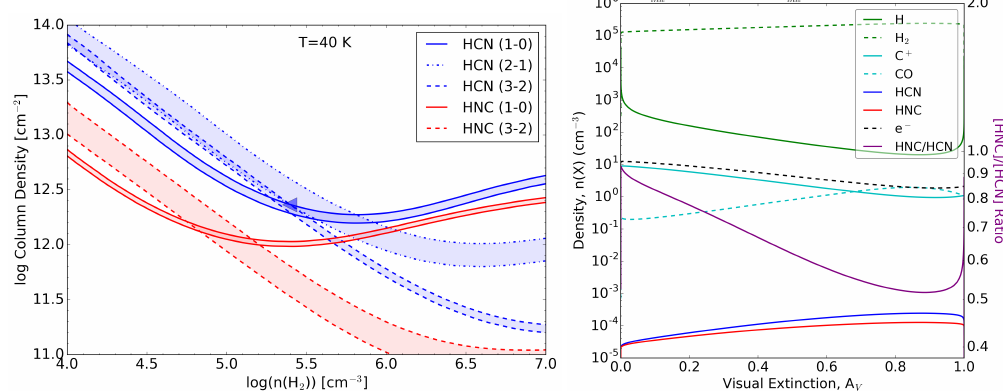
Figure 3. ( Left ) Sample RADEX predictions of molecular column and H 2 number densities resulting in the observed ranges (1 σ uncertainties) of HCN and HNC ( J = 1 → 0, 2 → 1, 3 → 2 ) line fluxes for Globule B, here assuming T kin = 40 K. Regions of overlap reveal narrow solution spaces in N(HCN, HNC) for temperatures below 60 K, while H 2 density remains degenerate for HNC. Convergence of all HCN transitions is marked (blue triangle). ( Right ) Meudon PDR modeling for a slab of gas with fixed pressure (P = 10 7 K cm − 3 ) confirms sub-unity HNC/HCN (purple) at increased depth and thus decreased UV penetration within the model globule. A noted increase in HCN compared to HNC (or decreasing HNC/HCN) at greatest depth of the slab contradicts the trend in Figure 1, suggesting an incomplete understanding of the chemical processes within the Helix globules. We have also plotted densities for additional species such as H and C + (green and light blue, respectively) that are commonly used as tracers of irradiation, density,